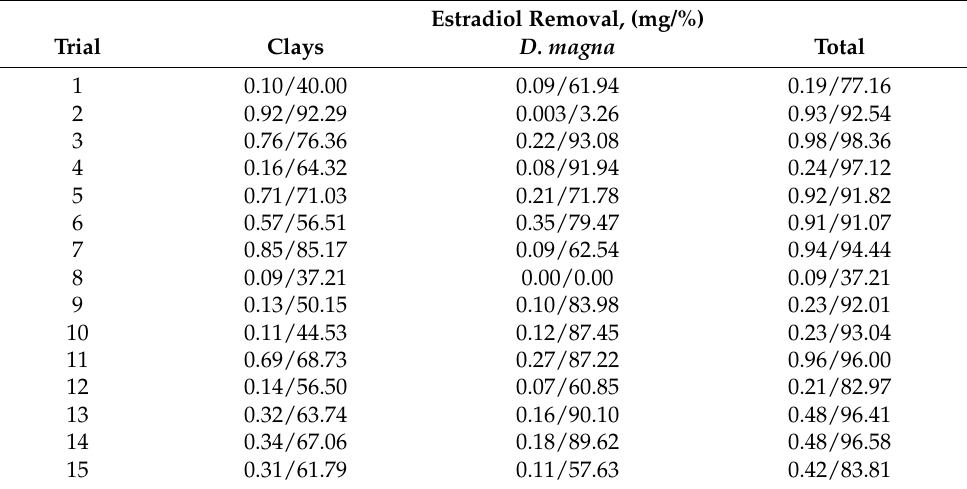
Table 5. Amount and percentage of estradiol removal obtained in each applied treatment. Estradiol Removal, (mg/%) Trial Clays D.